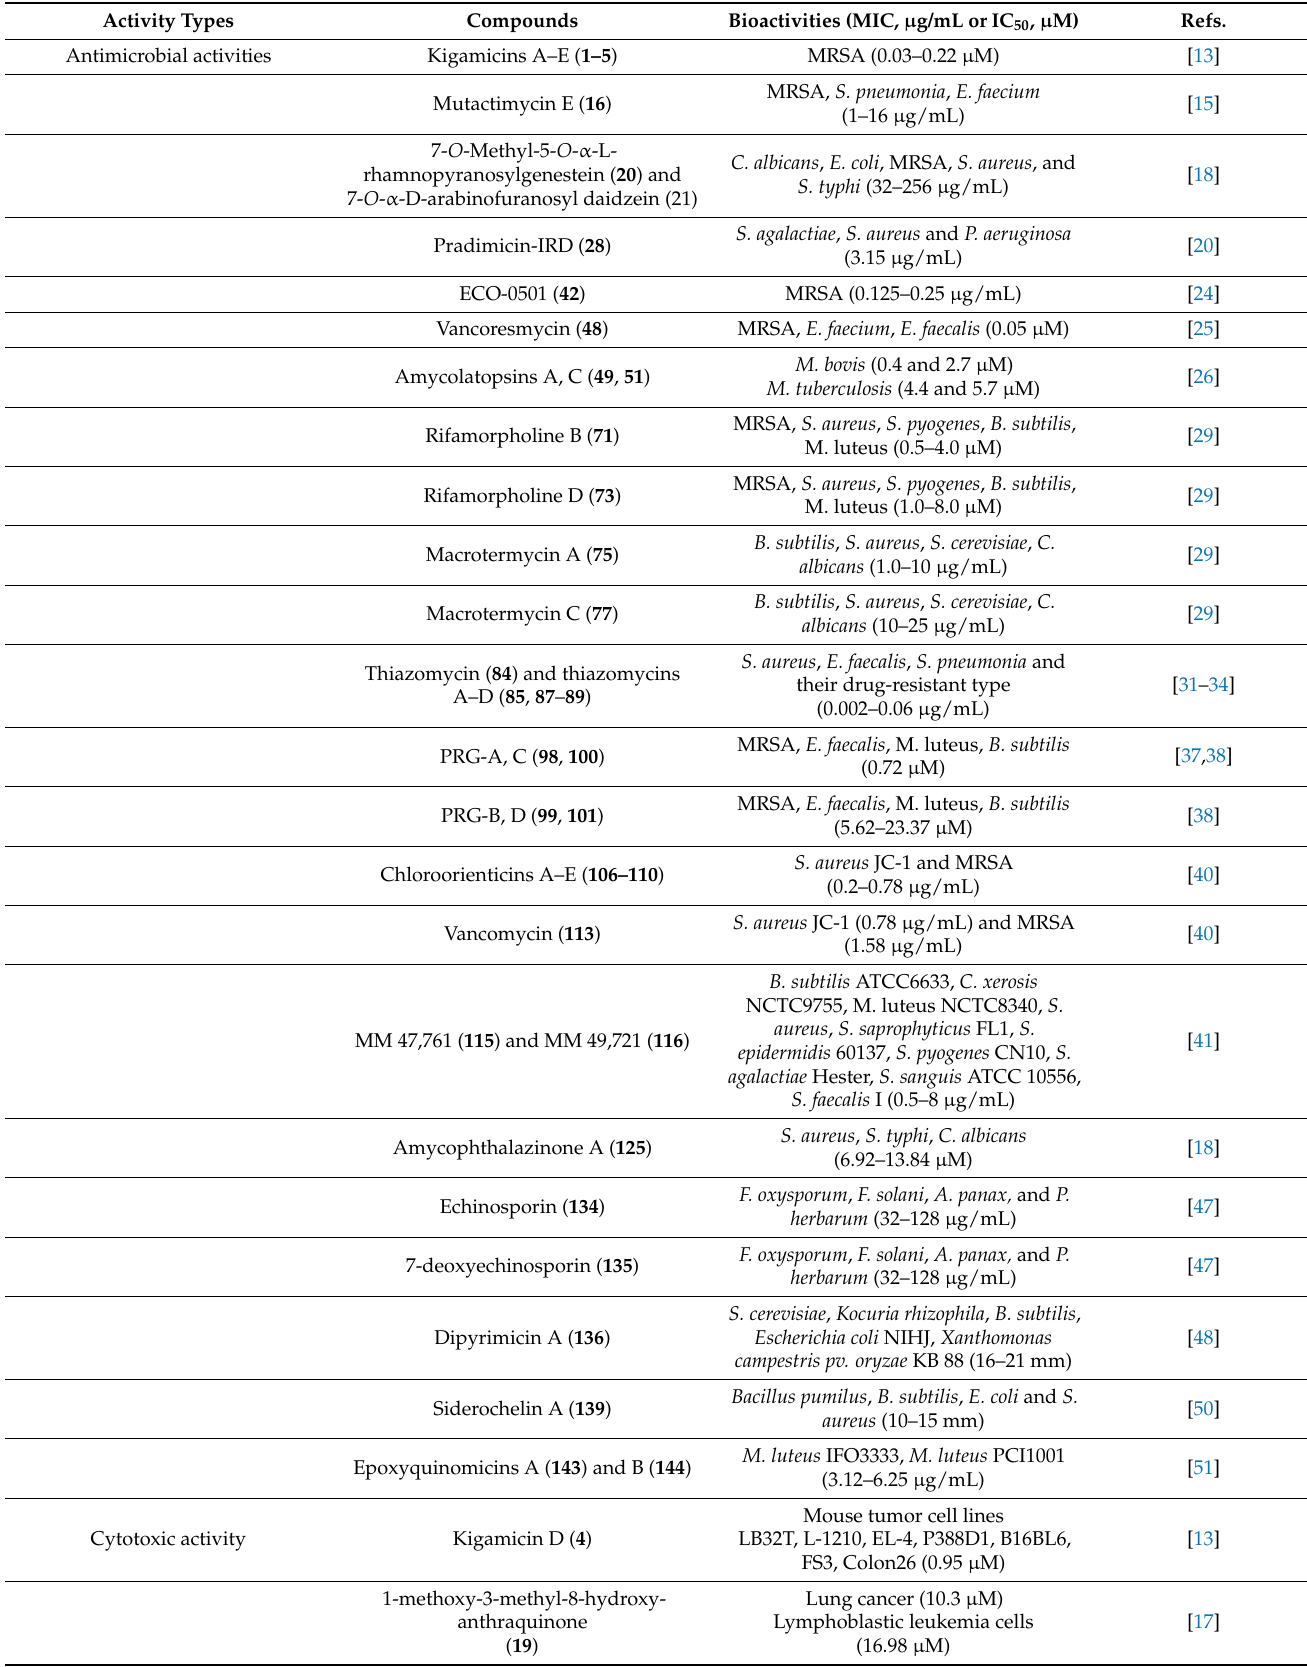
Table 2. The antimicrobial, cytotoxic and other bioactivities of secondary metabolites from Amycolatopsis